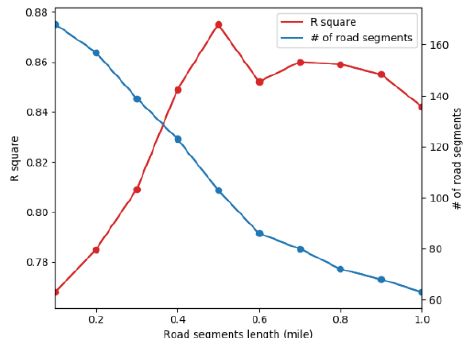
Figure 5. Threshold selection for road segment length